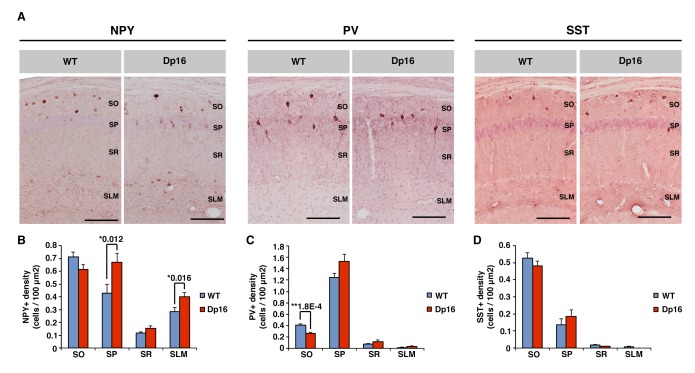
Neuropeptide Y-positive interneuron density is increased in the CA1 of Dp(16)1Yey mice.(A) Anti-neuropeptide Y (NPY), anti-parvalbumin (PV) and anti-somatostatin (SST) immunochemistry allow the visualization of specific populations of interneurons within the stratum oriens (SO), stratum pyramidale (SP), stratum radiatum (SR) and stratum lacunosum moleculare (SLM) of the CA1 area of hippocampus. (B) The density of NPY positive cells was significantly increased in the SR and SLM of Dp(16)1Yey mice. (C) The density of PV positive neurons was significantly decreased in the SO of Dp(16)1Yey mice, but remained comparable to WT in the SP where the majority of the PV positive cells are found. (D) The density of SST positive neurons was not significantly different between Dp(16)1Yey and WT samples in all four layers of the CA1. Values are expressed as mean ±standard error of the mean. Statistical significance was assessed using Mann-Whitney U-test (B–D) with significance set at (*) p<0.05 and (**) p<0.01. Scale bars in (A) correspond to 50 μm.10.7554/eLife.31543.017Figure 5—source data 1.Quantification of interneuron populations density - full data set.